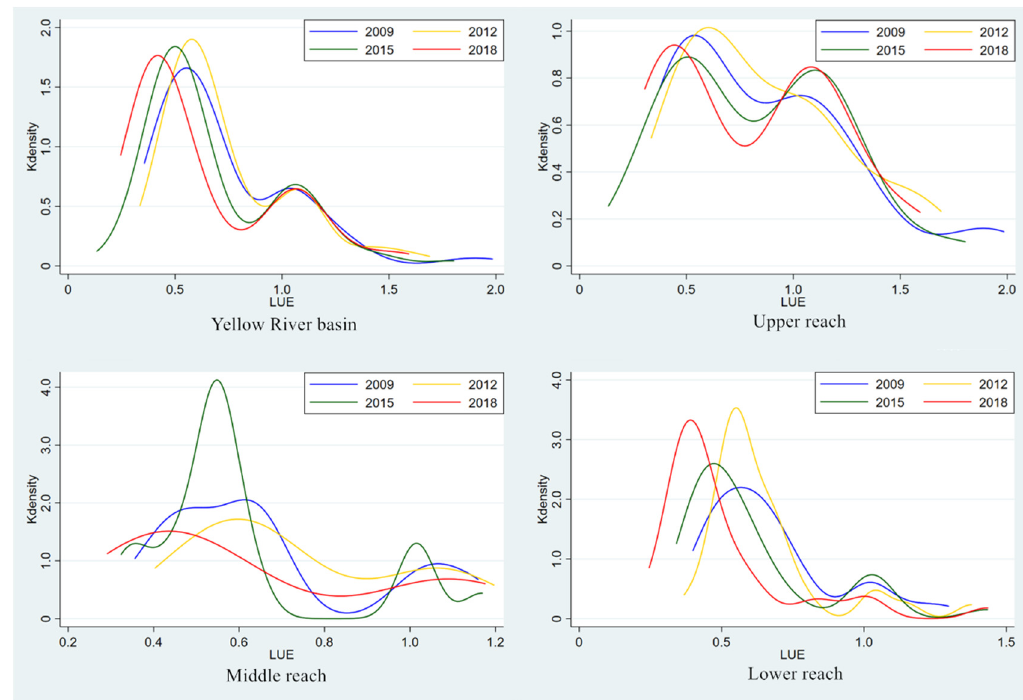
Figure 5. Kernel density curve of LUE from 2009 to 2018.